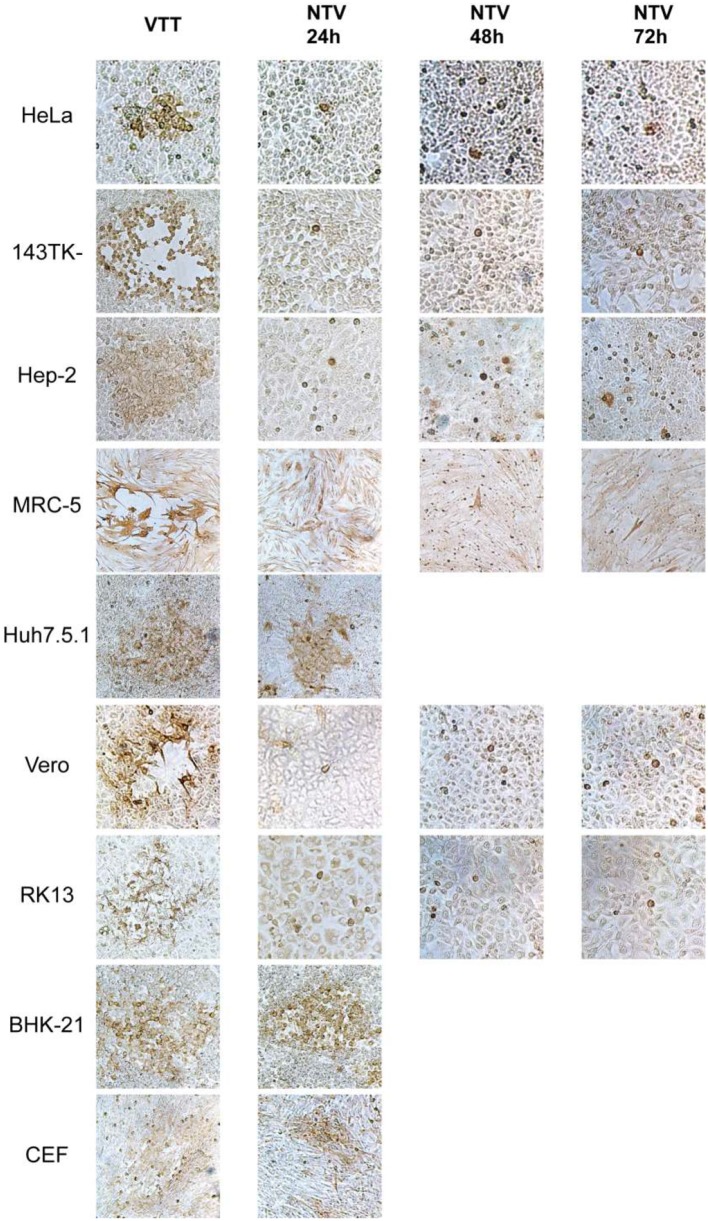
Cell-to-cell dissemination of NTV. The indicated cells were infected with NTV or VTT at an MOI of 0.005, fixed at 24, 48, or 72 h p.i. and immunostained with anti-VACV antibody, and then visualized using DAB reagent kit. VTT was used as control. All images were taken at 200X magnification.